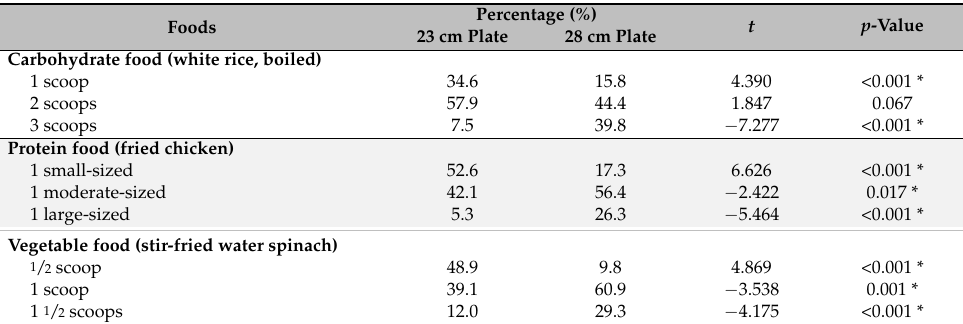
Table 8. Preferences of food portion size based on plate size ( n =